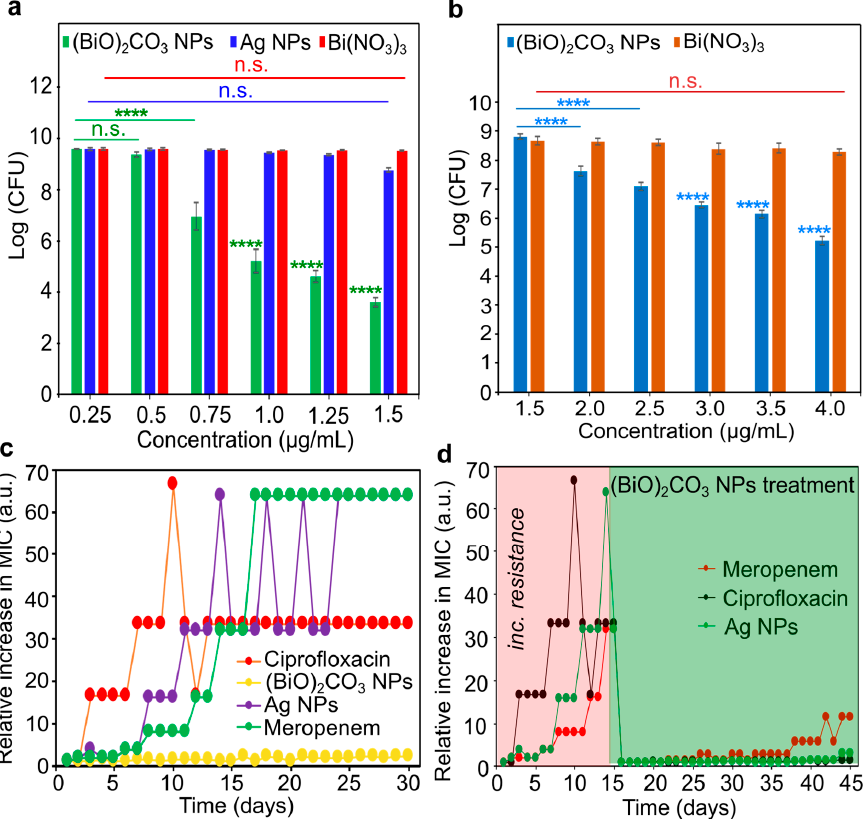
Figure 2. Antibacterial activity studies. ( a ) growth inhibitory curves of (BiO) 2 CO 3 NPs against DSPA vs. Bi(NO 3 ) 3 and AgNPs; ( b ) growth inhibitory curves of (BiO) 2 CO 3 NPs against DSSA vs. Bi(NO 3 ) 3 ; and ( c ) pro fi les of resistance development of (BiO) 2 CO 3 NPs vs. cipro fl oxacin, AgNPs and meropenem in DSPA after 30 days of treatment with each drug; and ( d ) declined drug resistance by the treatment of (BiO) 2 CO 3 NPs in the DSPA bacteria that are resistant to cipro fl oxacin, AgNPs and meropenem. Not signi fi cant (n.s.), and **** ( p < 0.0001).